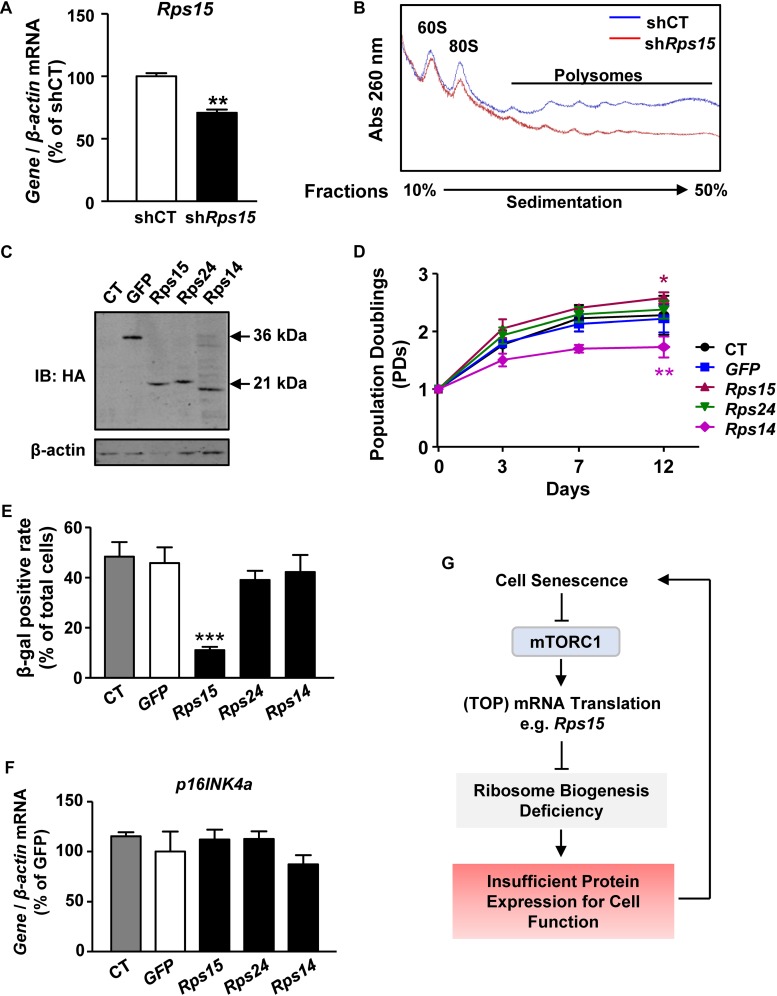
Rps15 is important for ribosome biogenesis and overexpression of Rps15 ameliorates senescent phenotypes in MEFs. (A) Relative quantification of Rps15 mRNA after knockdown Rps15 in MEFs. β-actin was used as internal control (Mean ± SEM, n = 3, ∗∗p < 0.01). (B) Polysomal profiles of shRps15 MEFs and negative control with continuous sucrose gradient of 10–50% were fractioned and measured with absorbance of light at 260 nm. Peaks belonged to large subunit of 60S, intact ribosome of 80S and polysomes were labeled. (C) Representative western blot analysis of untransfected control MEFs (CT) and overexpression of GFP, Rps15, Rps14, and Rps24 in extracts from respective stable-expression MEFs, recognized by anti-HA (mouse). β-actin was used as internal loading control. (D) Growth curves of Rps15, Rps24, Rps14, GFP stable transgenic MEFs and untransfected control MEF (CT) starting from passage 1 (Mean ± SEM, n = 3, ∗p < 0.05, ∗∗p < 0.01). (E) SA-β-gal positive rate of senescent Rps15, Rps24, Rps14, GFP stable-expression MEFs and untransfected control MEFs (CT) (Mean ± SEM, n = 3, ∗∗∗p < 0.001). (F) Relative quantification of p16INK4a mRNAs in senescent Rps15, Rps24, Rps14, GFP stable-expression MEFs and untransfected control MEFs (CT). β-actin was used as internal control (Mean ± SEM, n = 3). (G) A schematic model of mTORC1-Rps15 axis contributes in senescence-associated translation reduction.